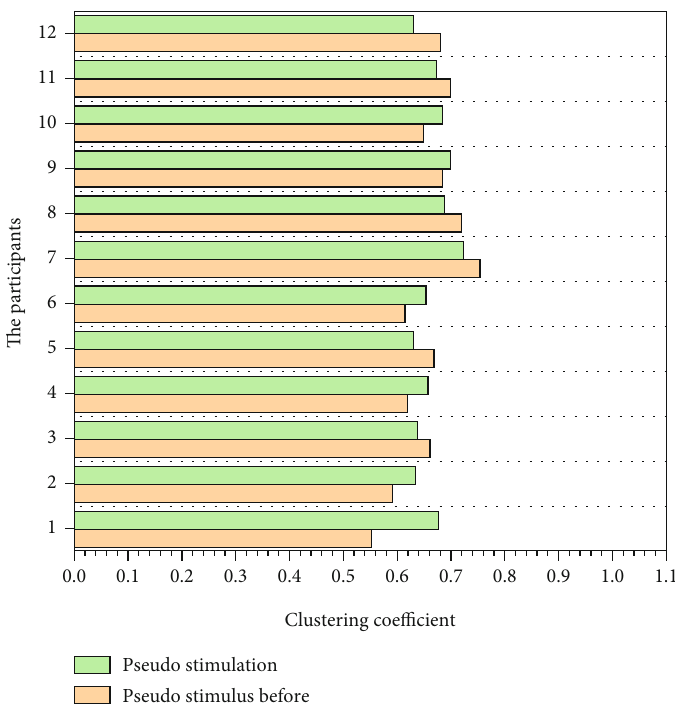
Figure 5: Network clustering coe ffi cient before and after pseudostimulus.